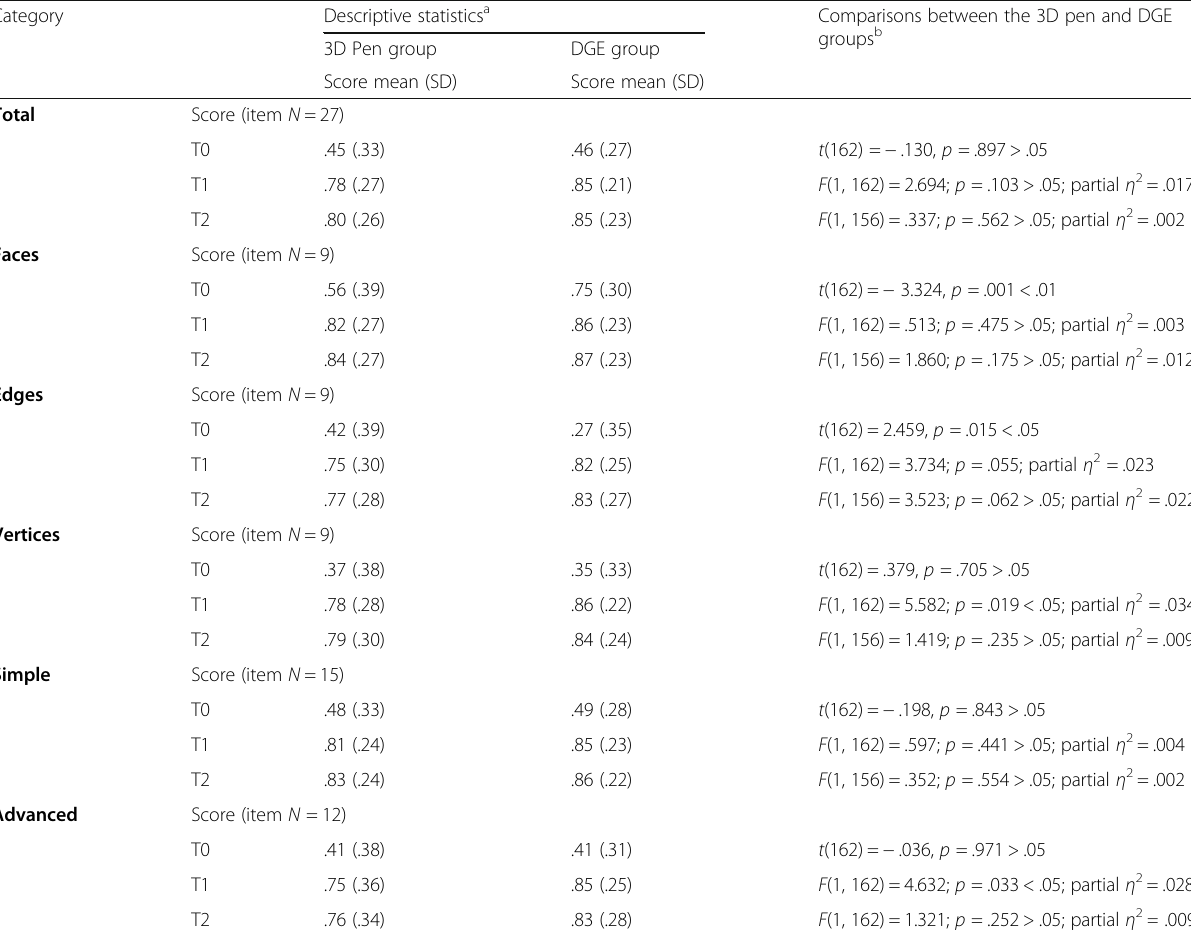
Table 3 Descriptive statistics and comparisons between the 3D Pen and DGE groups (by categories) Category Descriptive statistics